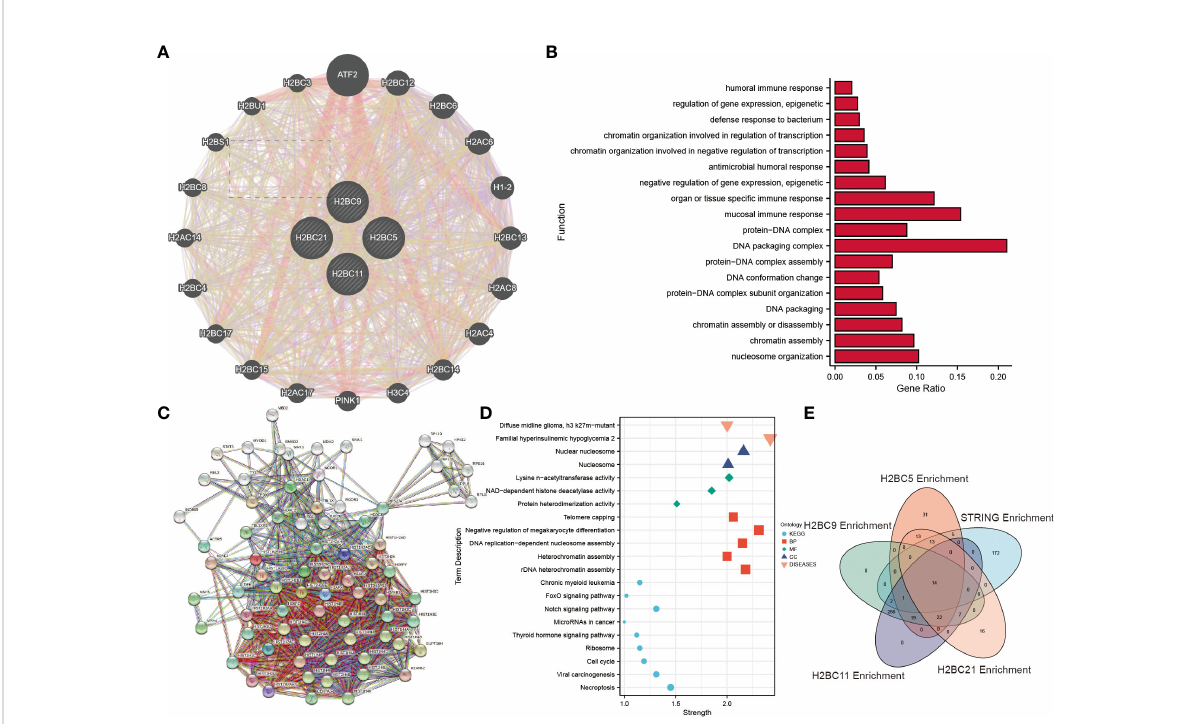
FIGURE 9 Enrichment analysis and protein-protein interaction (PPI) network of H2B genes. (A) . The 20 genes from the GENEMANIA database that were most related to H2BC5, H2BC9, H2BC11 and H2BC21 were enriched and analyzed. (B) Enrichment analysis results are displayed in a histogram. (C) A protein-protein interaction network for the 50 proteins most directly related to H2BC5, H2BC9, H2BC11 and H2BC21, and 20 indirectly related proteins, was constructed using the STRING database. (D) Some of the enrichment analysis results were displayed in dot plots. (E) Overlapping pathways and/or functions is shown using a Venn